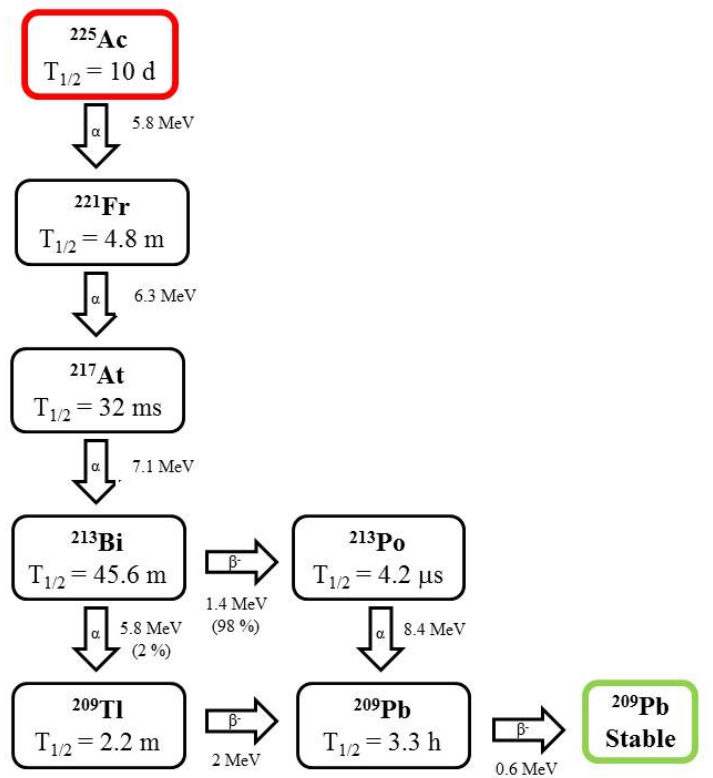
Figure 1. Decay schema of 225 Ac.